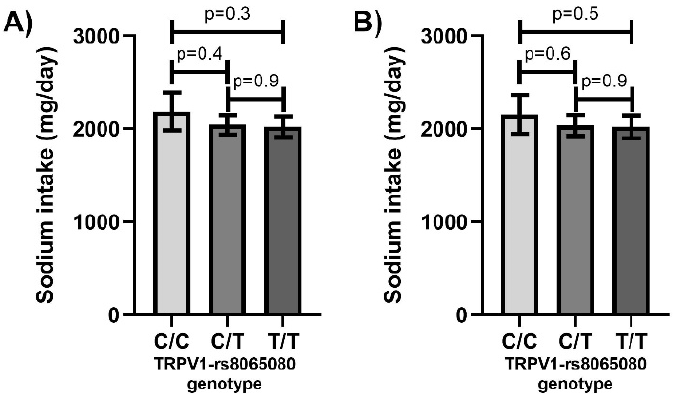
Figure 1. Sodium intake does not vary by TRPV1-rs8065080 genotype. ( A ) Unadjusted mean values ( B ) Least-squares means with adjustments for age, income and sex. Error bars mark 95% confidence intervals.